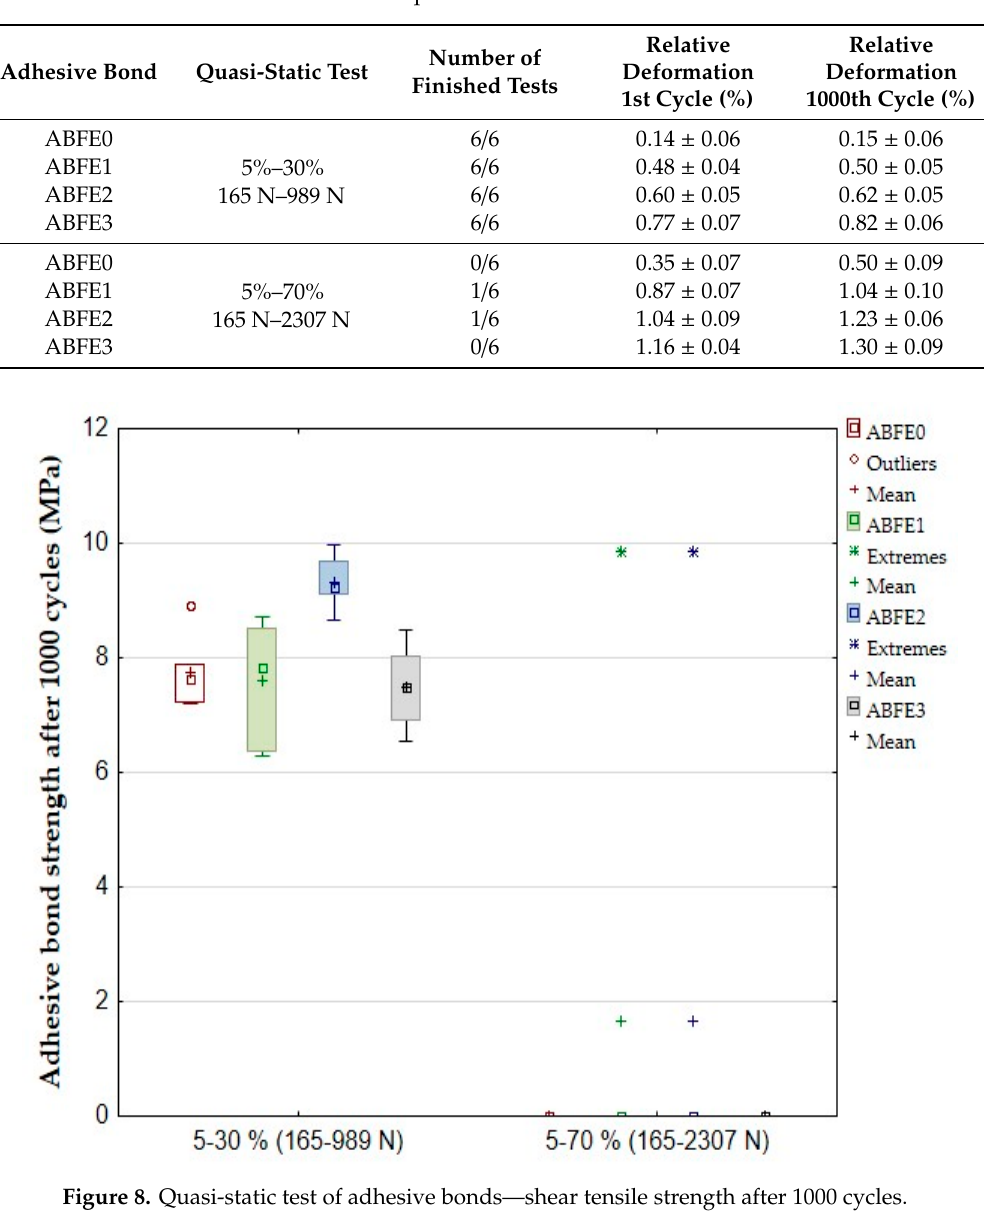
Table 4. Results of quasi-static test of adhesive bonds.